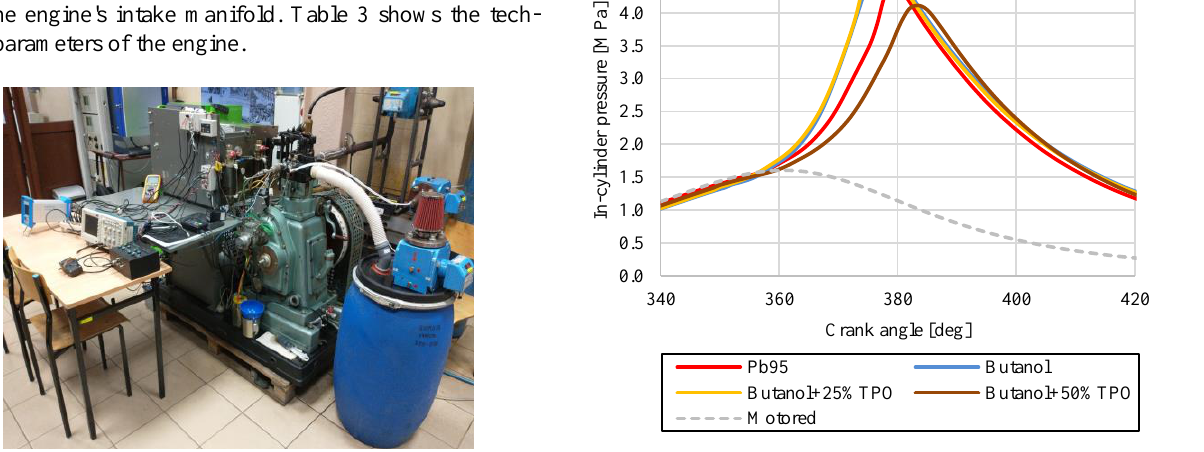
Fig. 4. View of the test stand with the UIT-85 engine